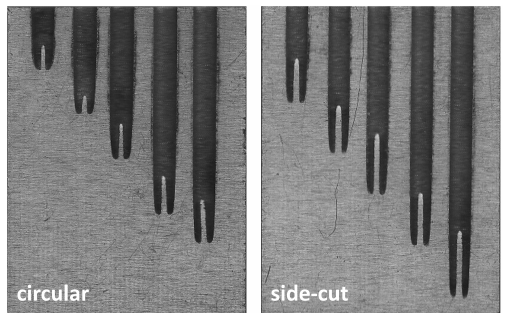
Figure 10. Results of TWR with respect to hole depth.